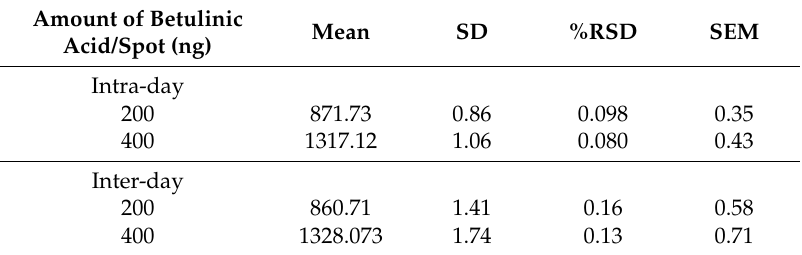
Table 2. Intra and Inter-day Method Precision ( n = 6).